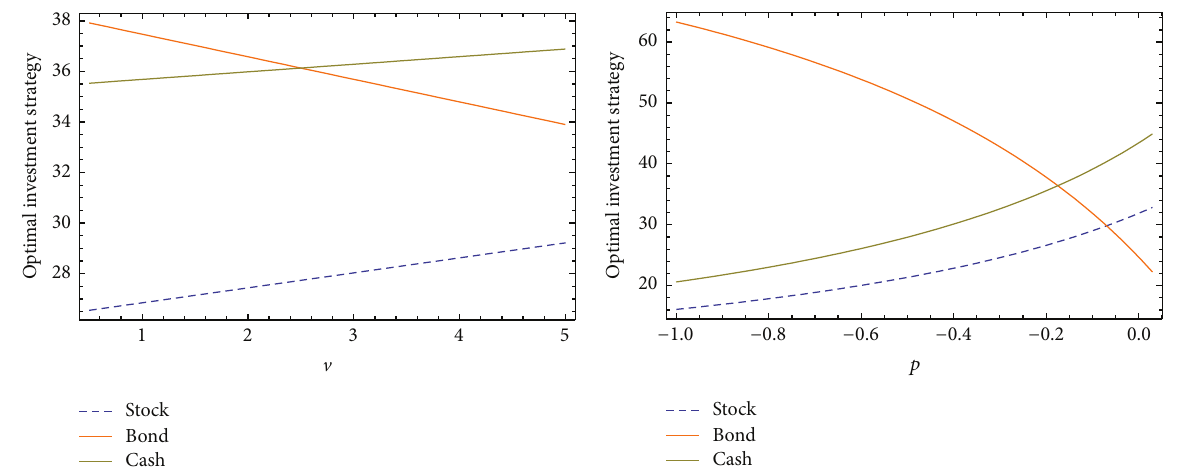
Figure 2: The effect of V and 𝑝 on the optimal